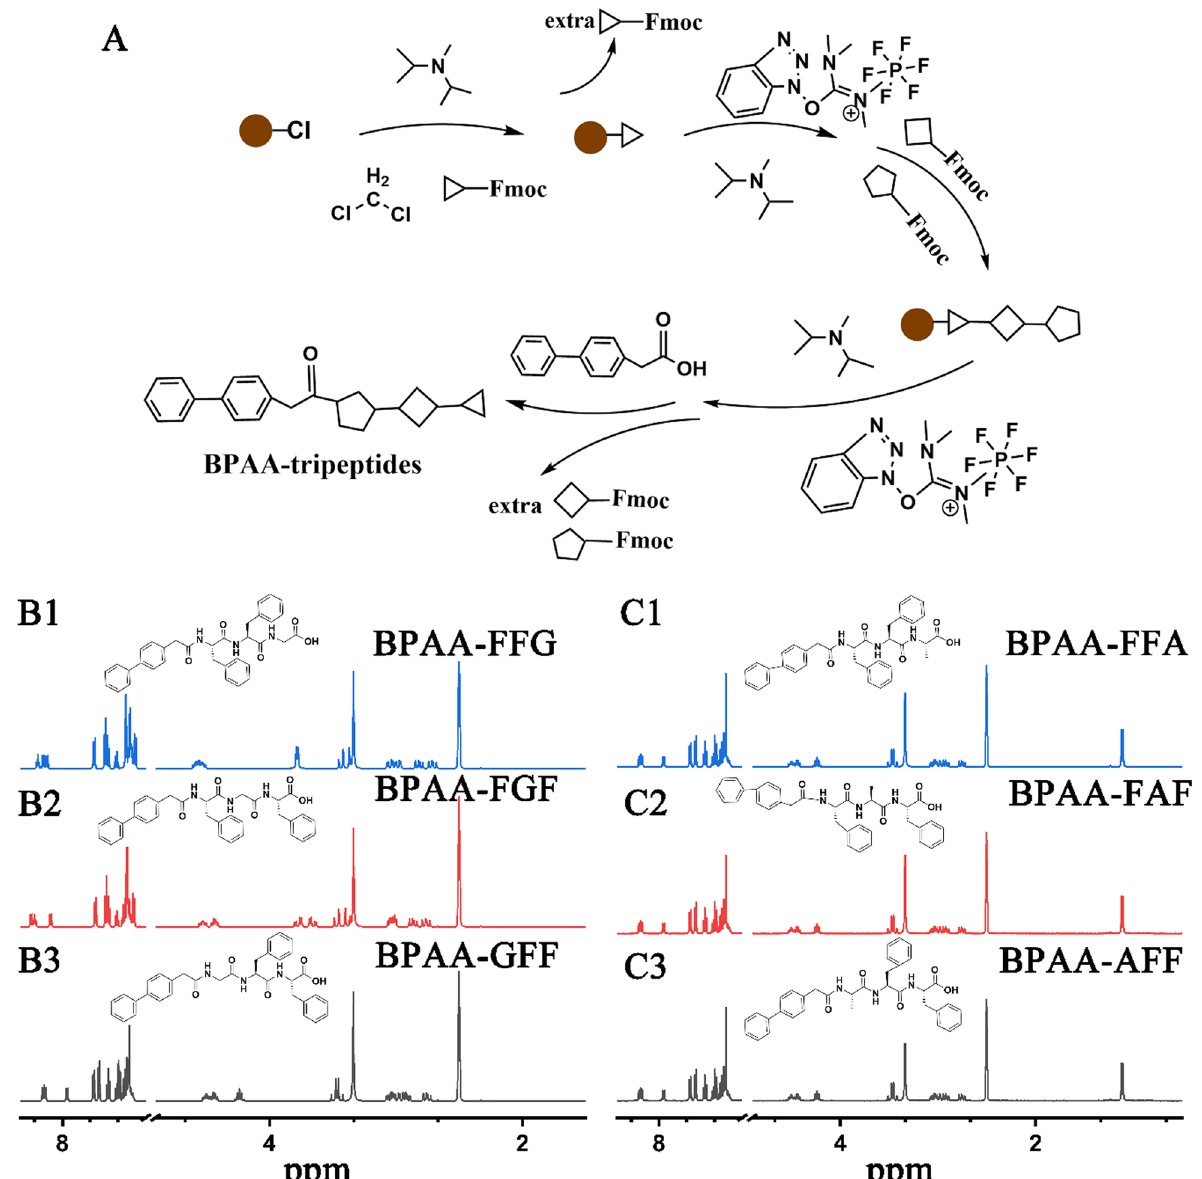
Fig. 1 A SPPS protocol of BPAA-tripeptide compounds. ( B1 – B3 ) H 1 -NMR (DMSO) spectra of BPAA-FFG-OH, BPAA-FGF-OH and